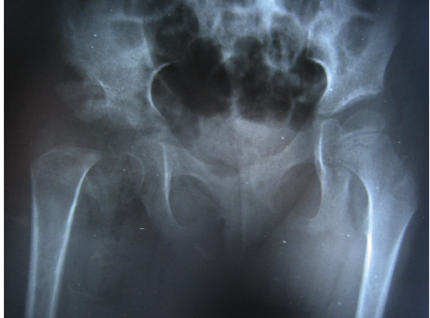
Figure 3: Right femoral neck fracture after passive motion under general anesthesia.